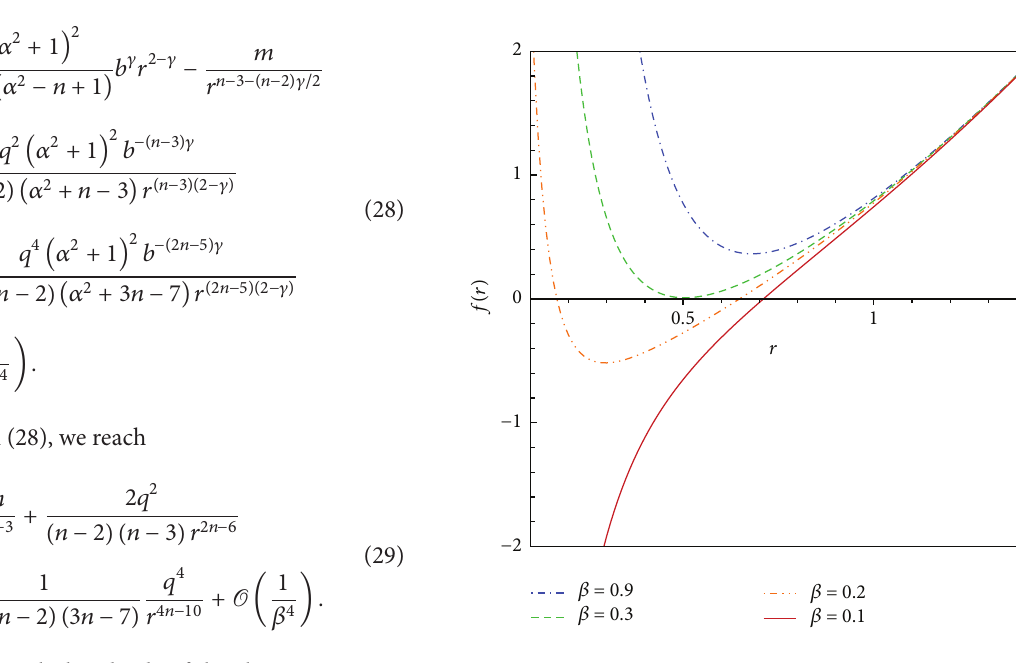
Figure 2: The behavior of 𝑓(𝑟) versus 𝑟 with 𝑙 = 𝑏 = 1 , 𝑞 = 0.8 , Ξ = 1.25 , 𝑛 = 5 , 𝛼 = 0.2 , and 𝑚 = 0.5